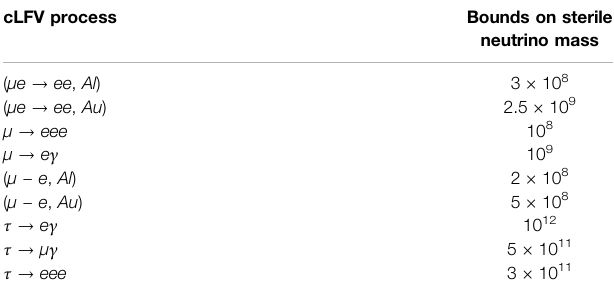
TABLE6| ConstraintsonthesterileneutrinomassfromdifferentcLFVprocesses. cLFV